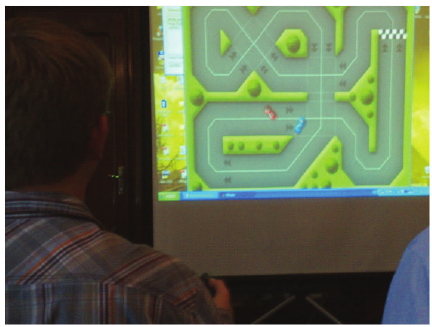
Figure 8: TiltRacer version 2 on a large public display.